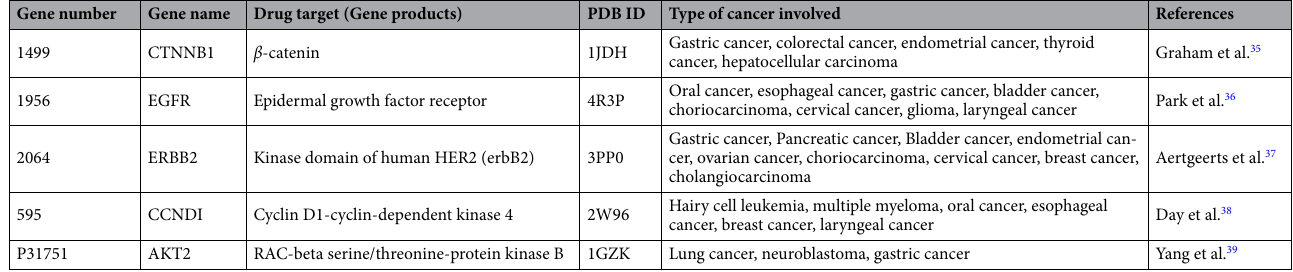
Table 6. Selection of probable drug targets from various types of cancers for structure based drug screening. The drug targets were screened based on the virulent function in the metabolic pathways of each type of cancer. The structural coordinates of these drug targets were retrieved from PDB.